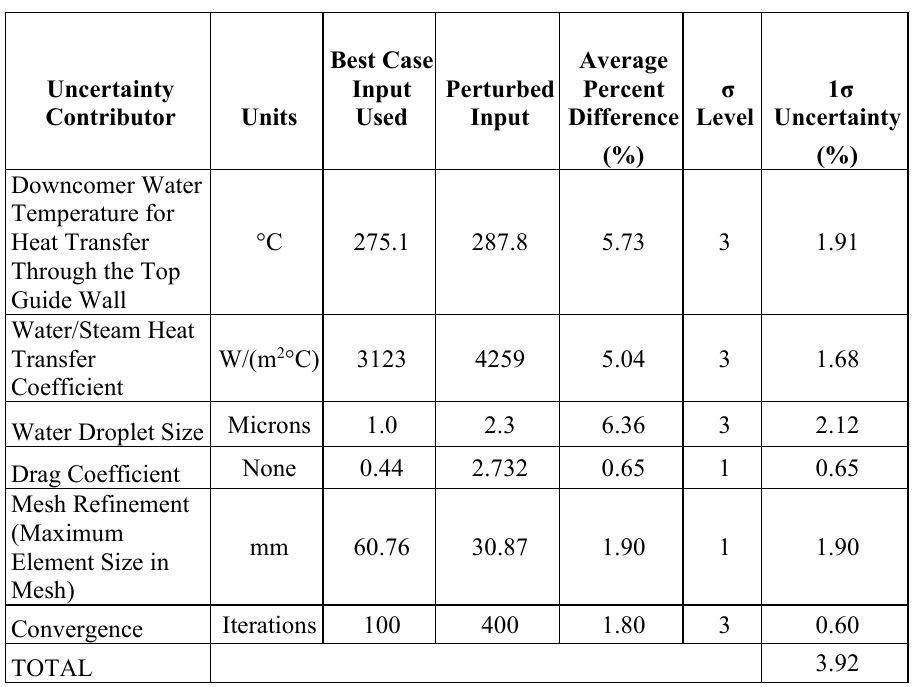
Table 2. CFD water density overall